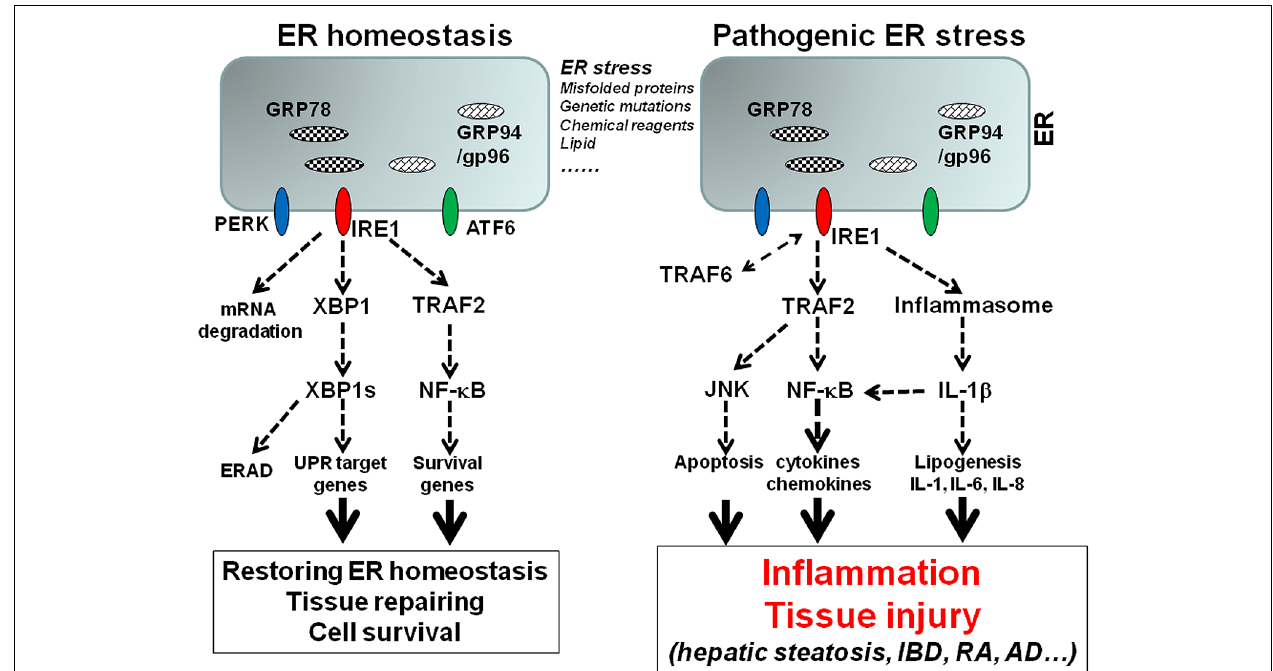
FIGURE 1 |The model of ER stress-associated inflammation. Accumulation of misfolded proteins, genetic mutations of ER stress molecules, or pharmacological compounds cause ER stress, which triggers the activation of three major UPR sensors: IRE1 α , PERK, and ATF6. Activation of IRE1 pathway leads to the unconventional splicing of XBP-1, which control the transcription of a group of UPR genes including GRP78 and GRP94.The interaction of IRE1 andTRAF2 leads to NF- κ B activation, which upregulates survival genes.The signaling and transcription programs initiated by IRE1 and